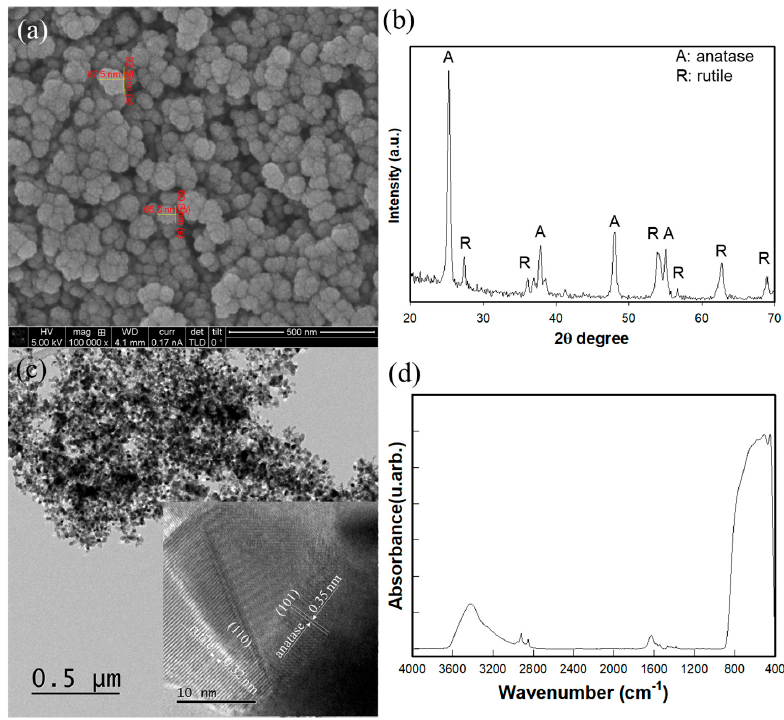
Figure 2. Characterization of TiO 2 : ( a ) SEM analysis, ( b ) XRD analysis, and ( c ) TEM analysis (insert: HR-TEM analysis) and ( d ) FTIR analysis.